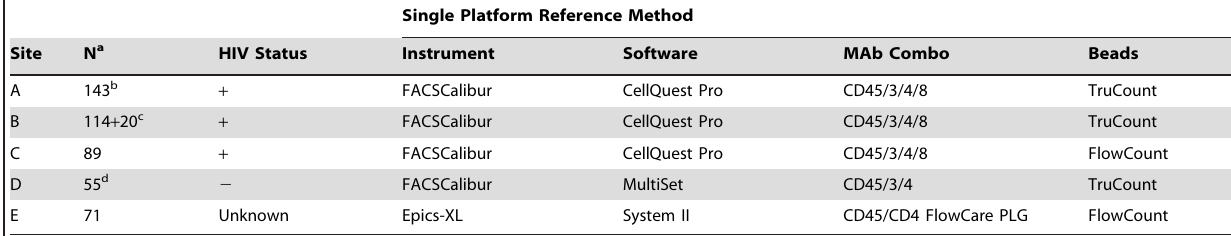
Single Platform Reference